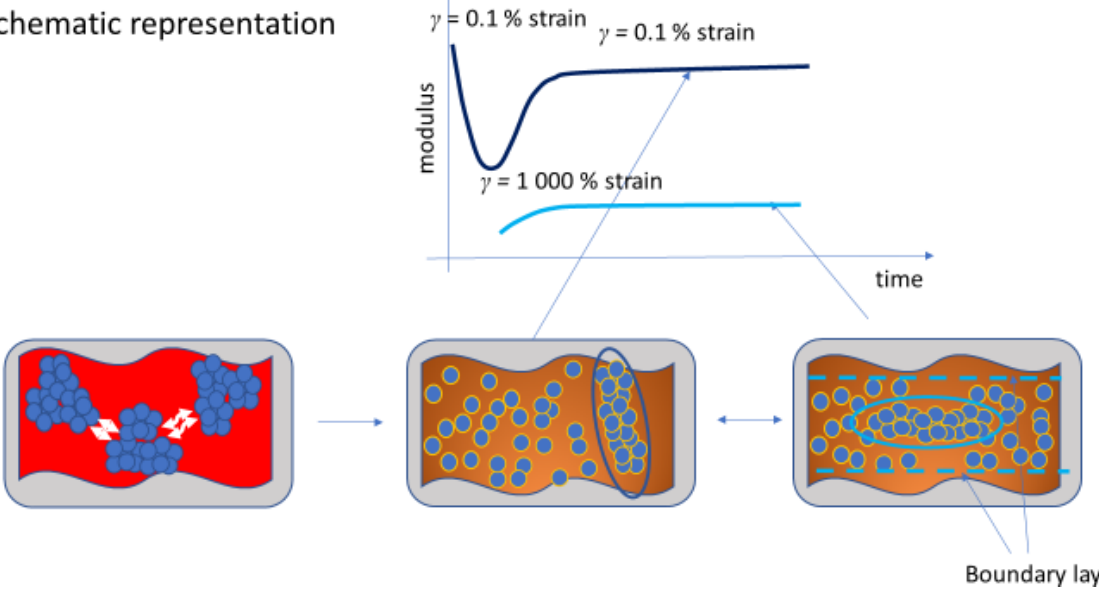
Figure 10: Schematic proposed to represent the three major states of structure in relation to the static condition followed by strain coupling with, or decoupling from, retained (or induced) agglomerates. The stochastic transition between the two states provides an indicator of the state of dispersion versus structuration of the particles in